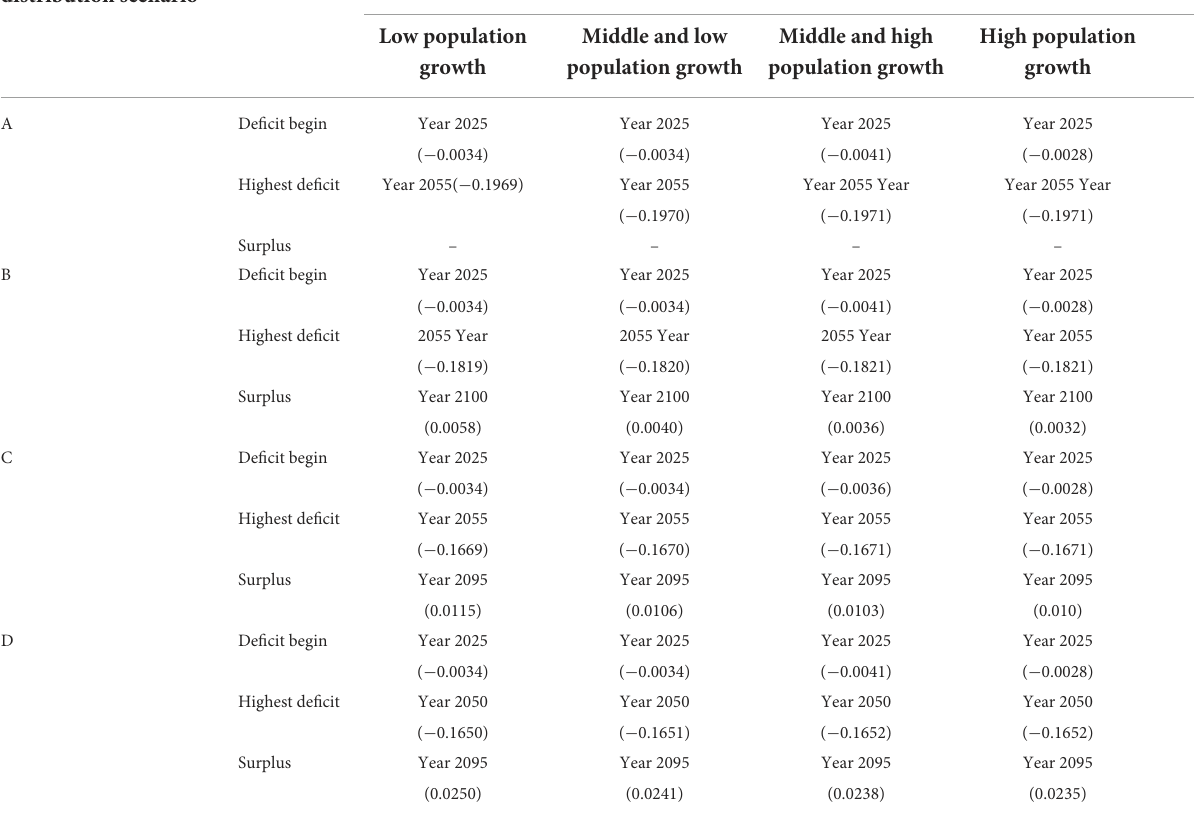
TABLE 3 Financial deficit or surplus of the LTCI system as a percentage of GDP under the high economic growth scenario (%). Disposable